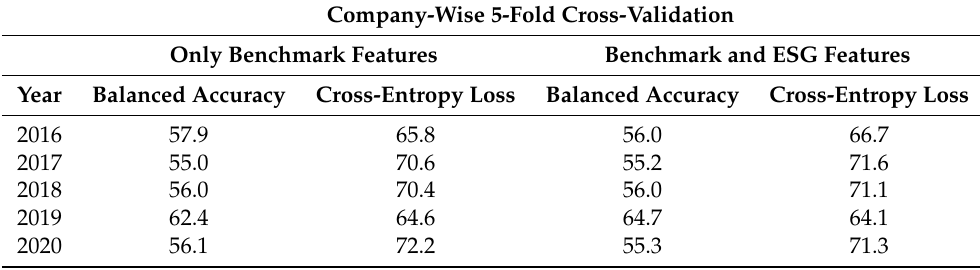
Table A2. Performance measures in percentage on the test set for a target computed using the Fama–French 3-factor